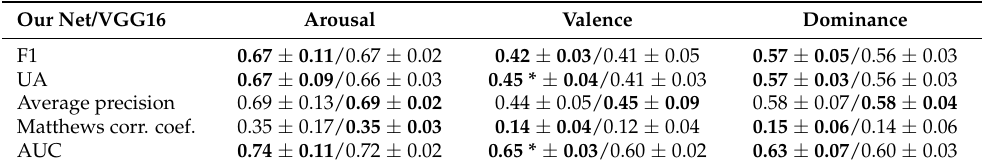
Table 3. Classification performance of our proposal and VGG16 for the VAD model prediction task. Comparisons where a network significantly outperforms the other (i.e., p -value < 0.05) are marked with the symbol *. The best result for each comparison is highlighted in